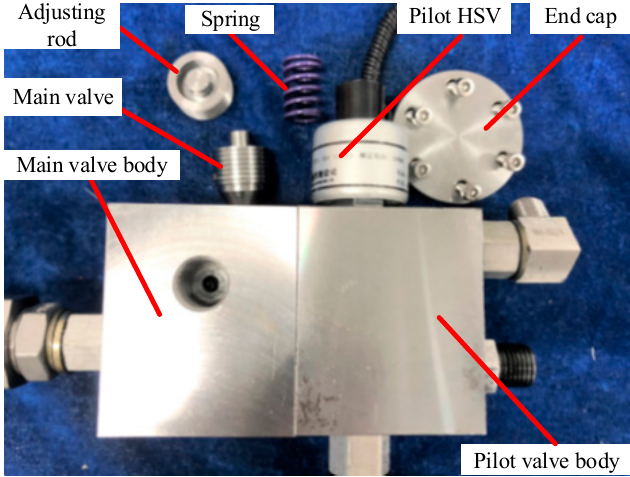
Figure 8. A prototype of the proposed AMOHSV.